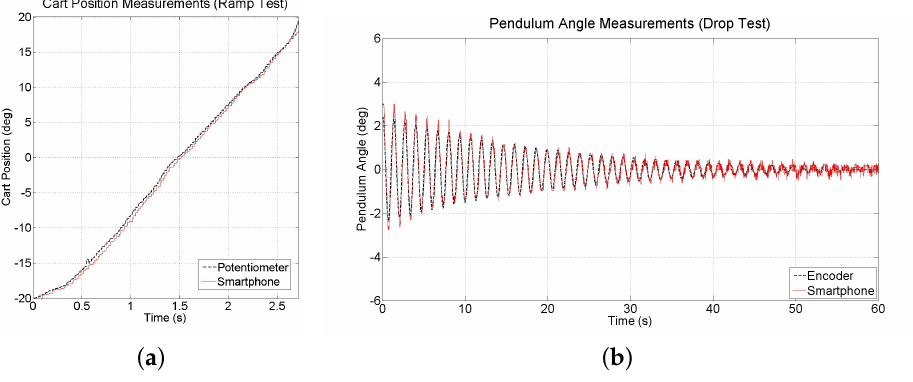
Figure 14. Measurements of ( a ) cart position collected during a ramp test and ( b ) pendulum angle collected during a drop